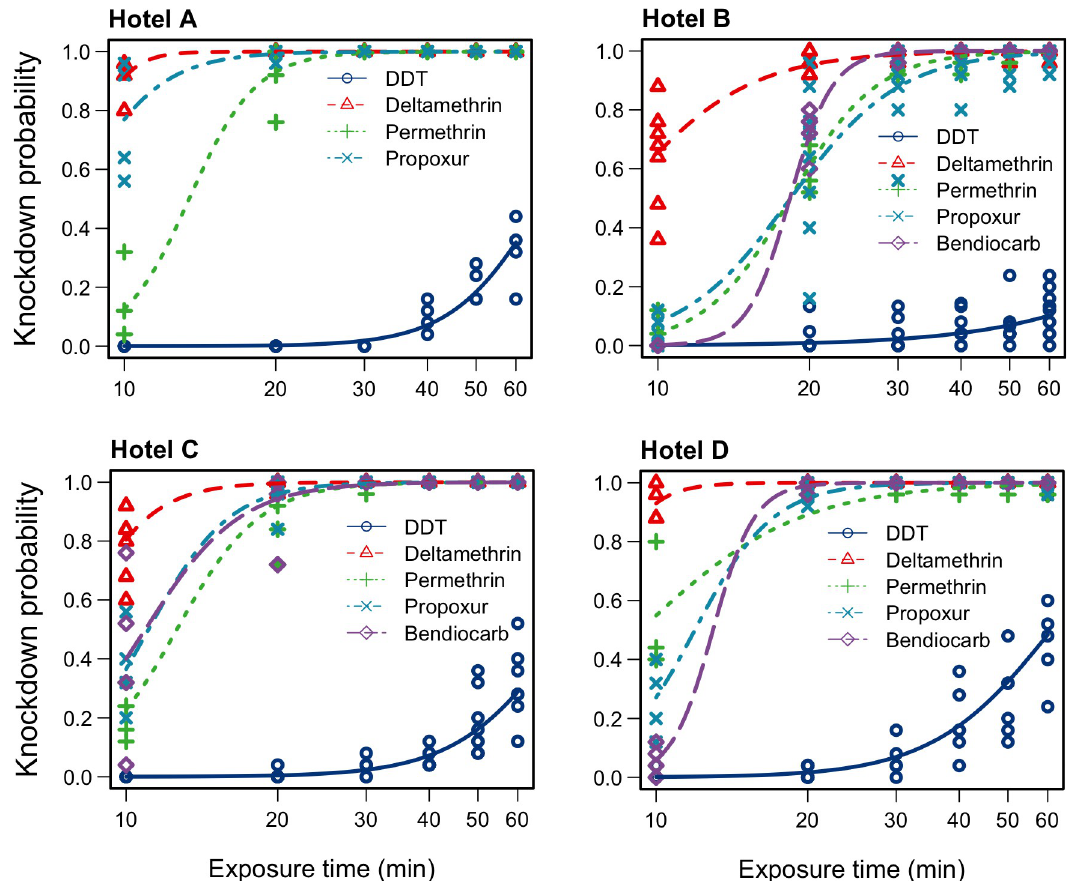
Fig 2. Knockdown probability of Aedes aegypti exposed to discriminant doses of insecticides. Consistent delayed knockdown of Ae . aegypti exposed to DDT is visible at all sites, which indicates